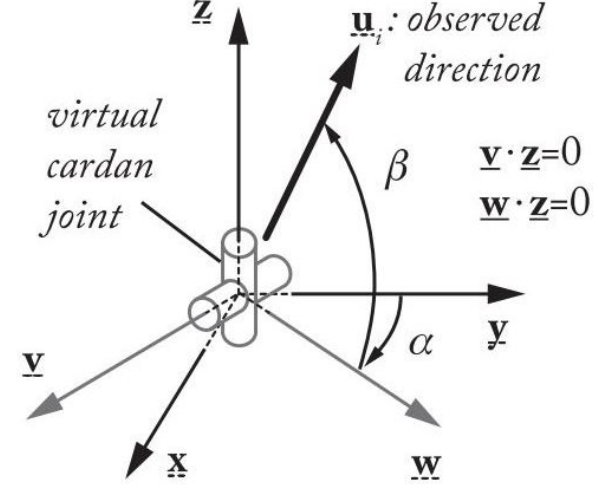
Figure 5. A unit vector u i in space and its parameterization.